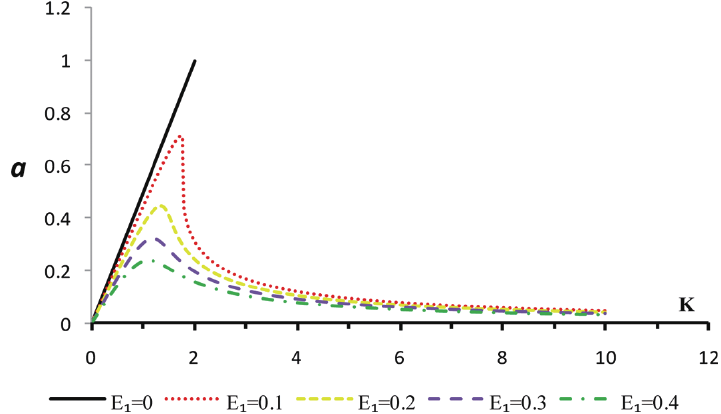
Fig. 2. Variations of a in terms of K for different values E 1